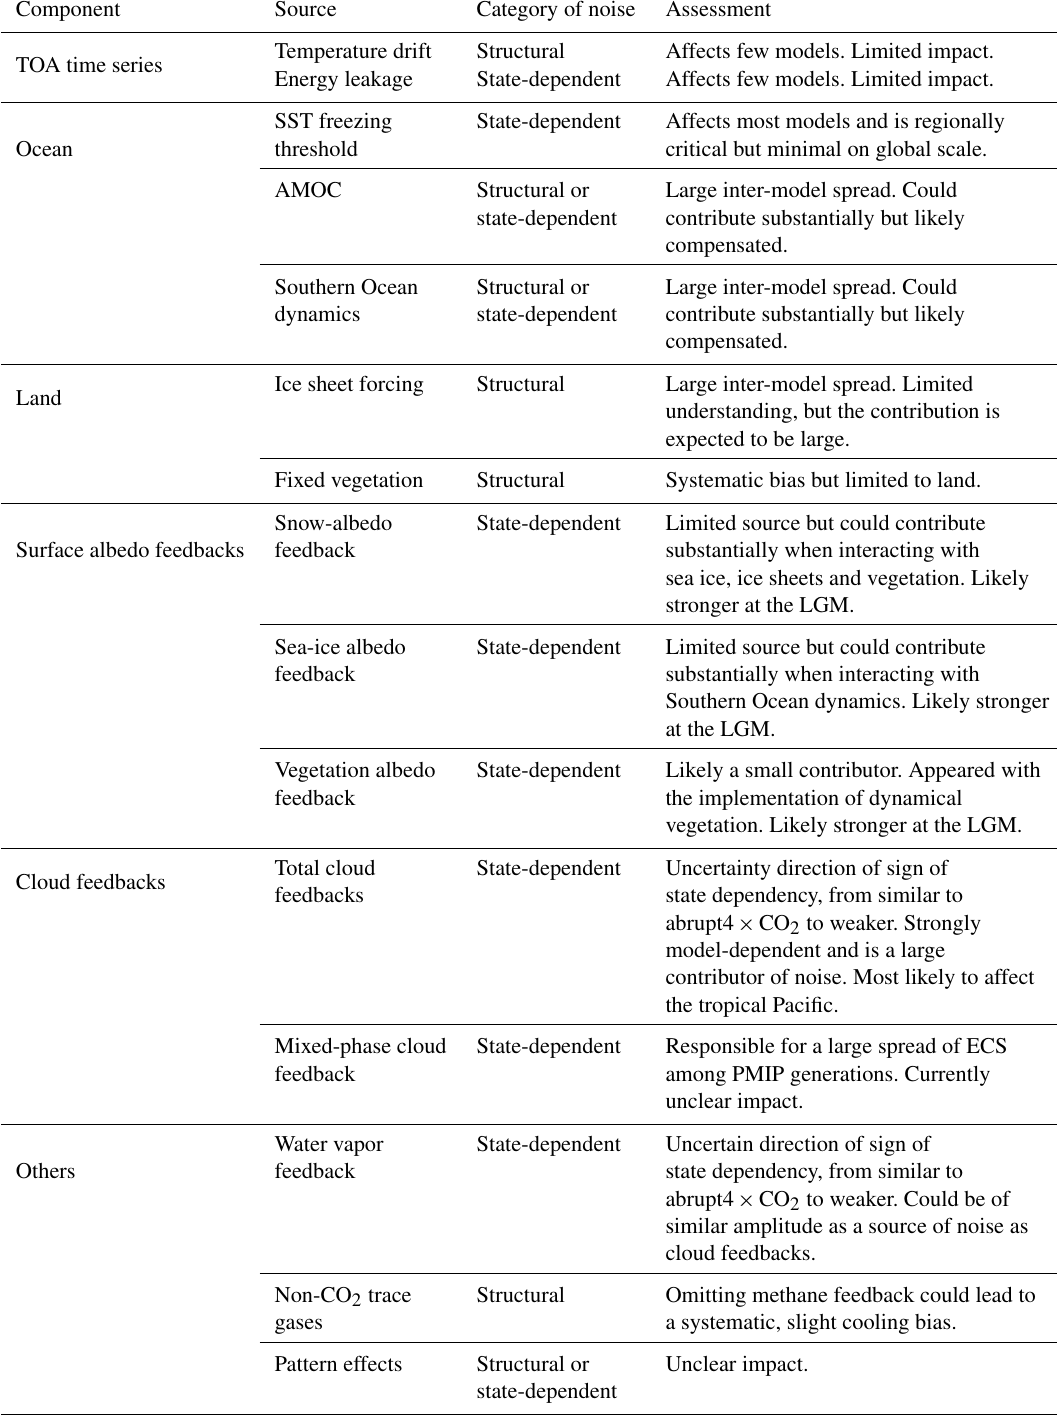
Table 7. Assessment of the different sources of noise as well as whether they arise from structural uncertainties in representing the LGM or state dependency and varying strength between cold and warm climate. If the category of noise is written within parentheses, then it is regarded as plausible but less dominant than the category outside